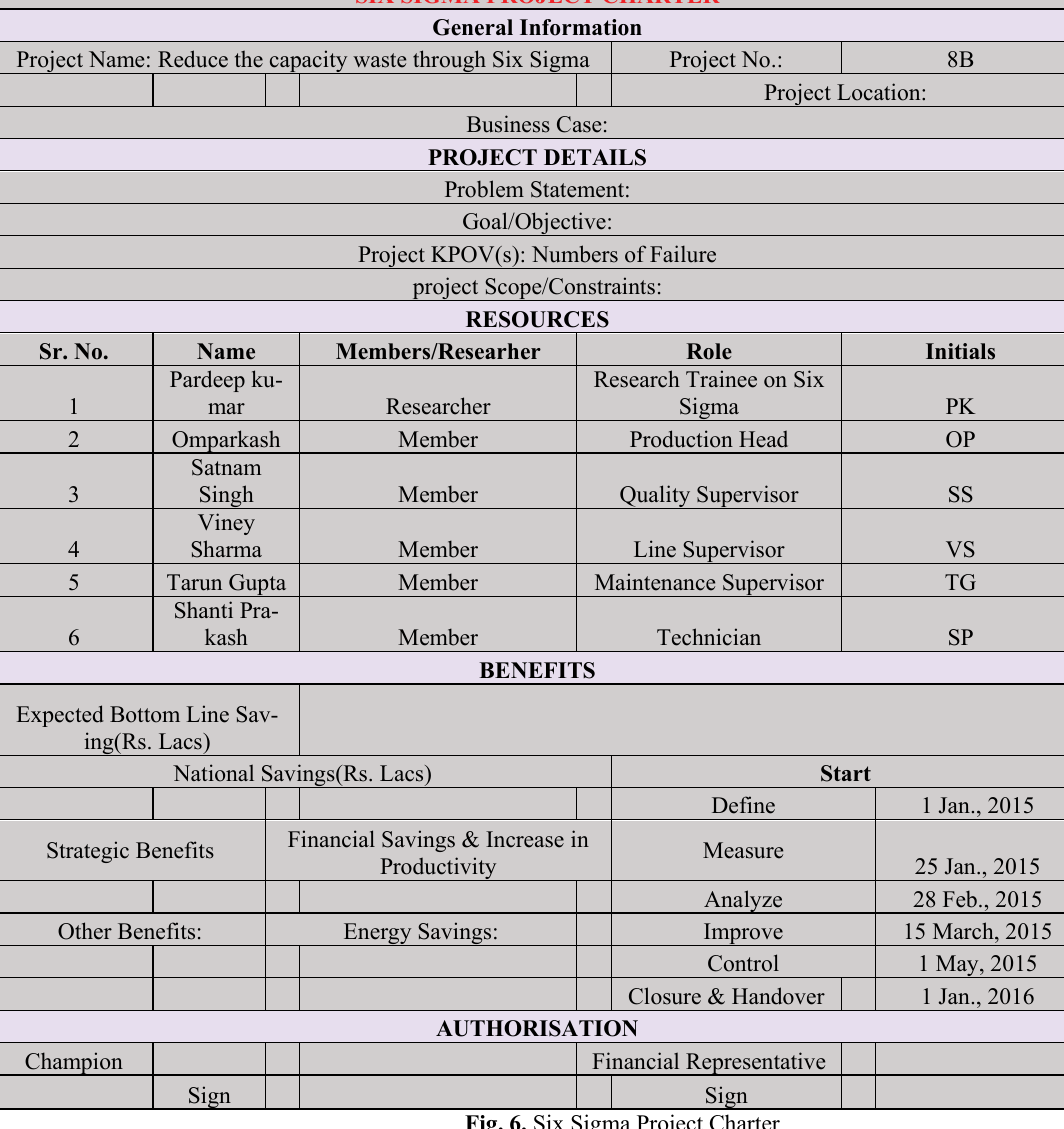
Fig. 6. Six Sigma Project